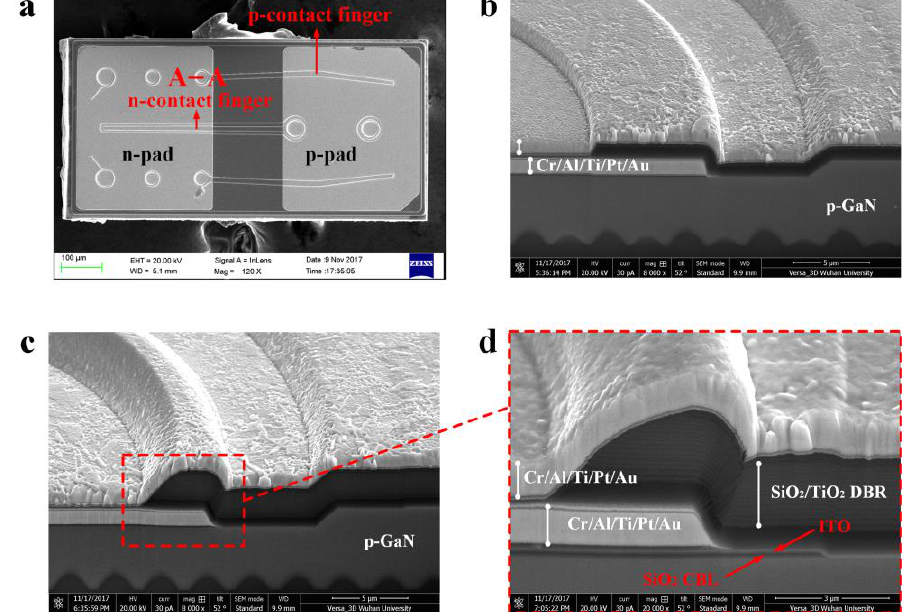
Figure 4. ( a ) Top-view SEM image of the fabricated FCLED with DBR. ( b ) Cross-sectional SEM image of the FCLED without DBR. ( c ) Cross-sectional SEM image of the FCLED with DBR. ( d ) Magnified Cross-sectional SEM image of the FCLED with DBR.